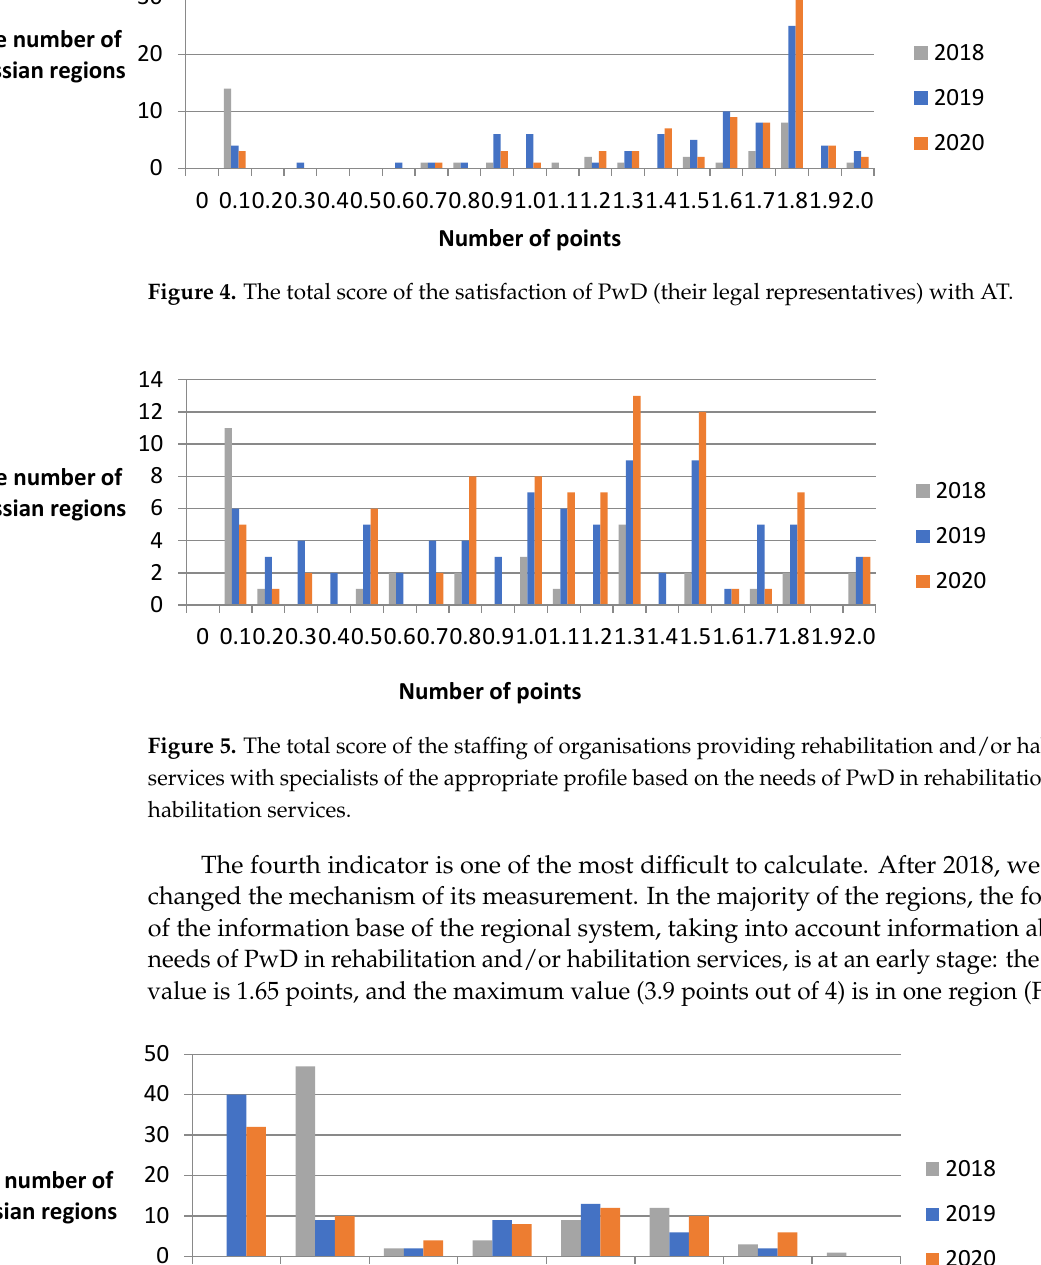
Figure 6. The total score of the formation of the information base of the regional system, taking into account information about the needs of PwD in rehabilitation and/or habilitation services.